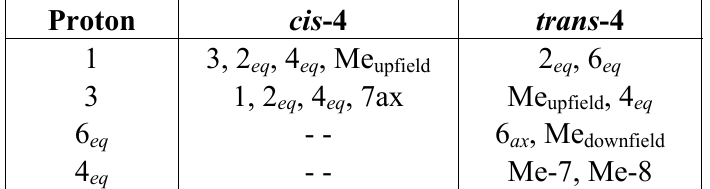
, H , H and H 1 3 4eq 6eq